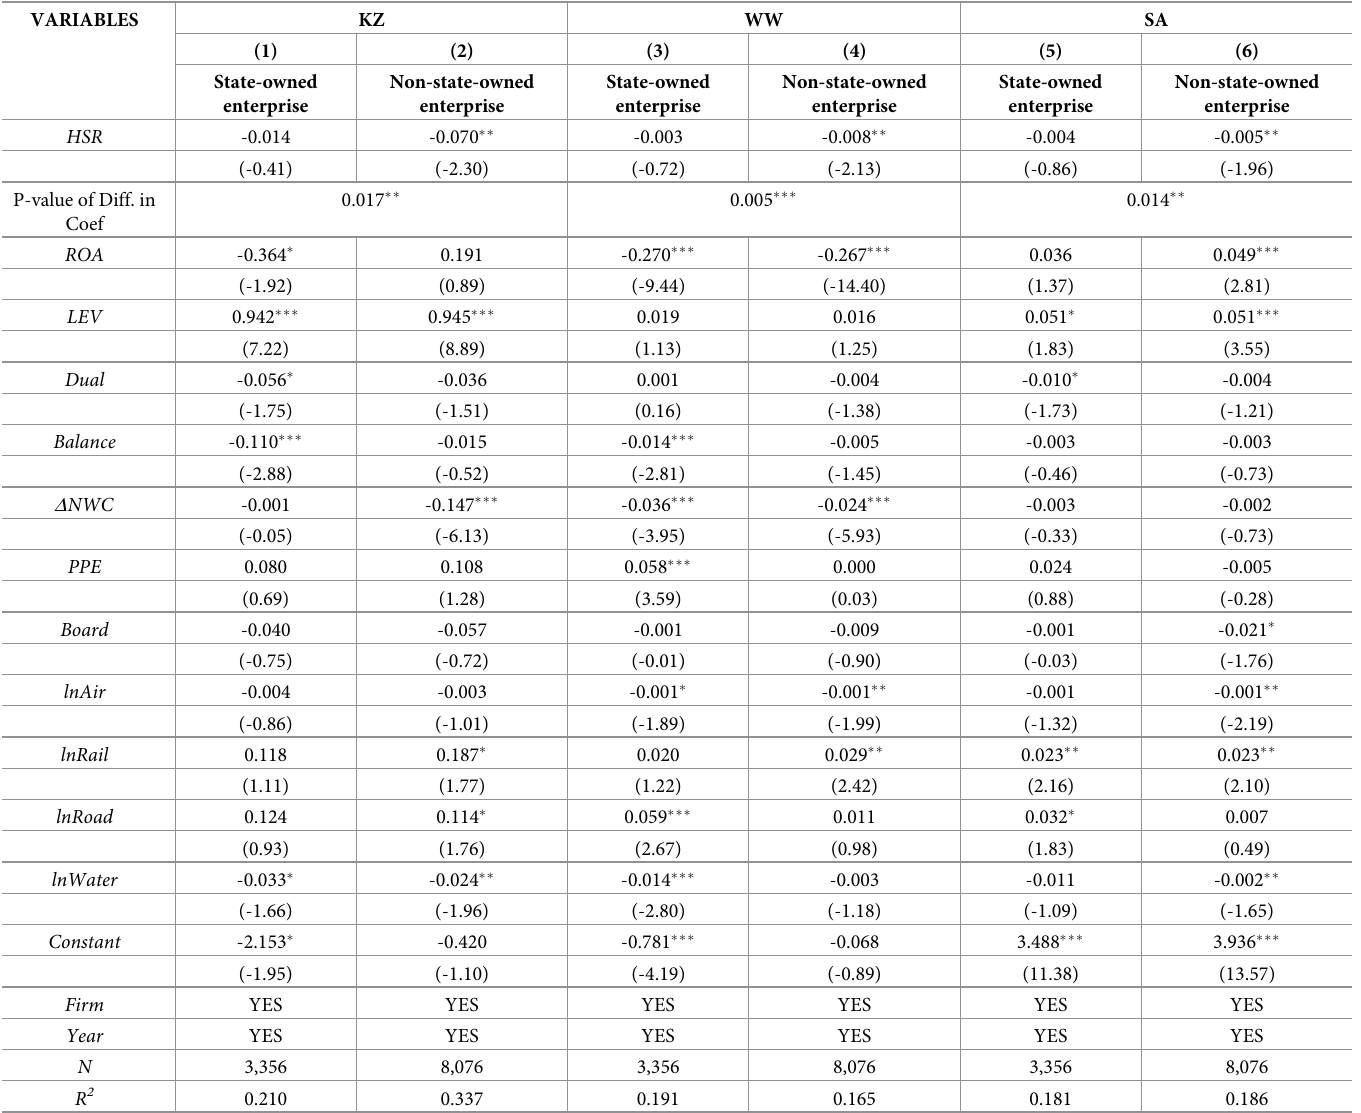
Table 4. Regression results of different property